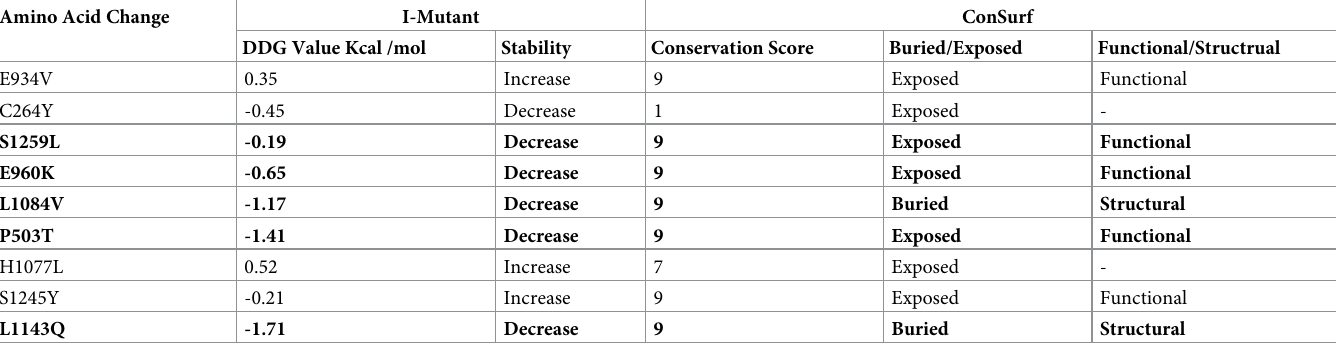
Table 2. Analysis of protein stability and evolutionary conservation profile of high risk nsSNPs of MTUS1 by I-Mutant and ConSurf. Amino Acid